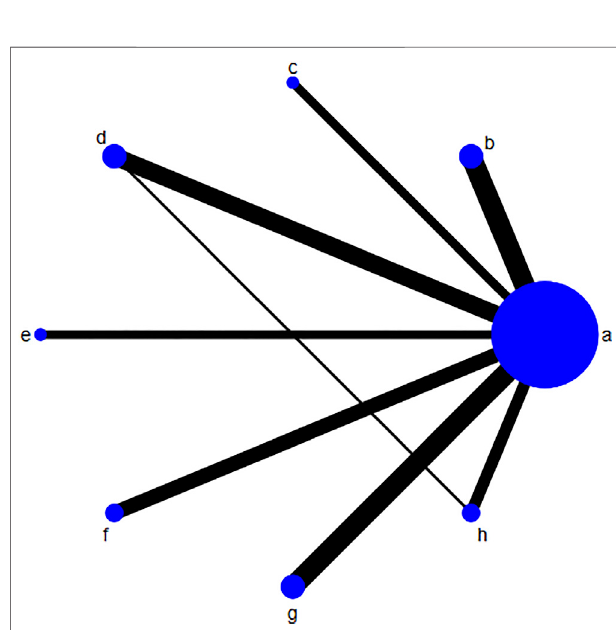
number table method to group included studies. A double-blind method was used in a study (Hu and Yang, 2013).